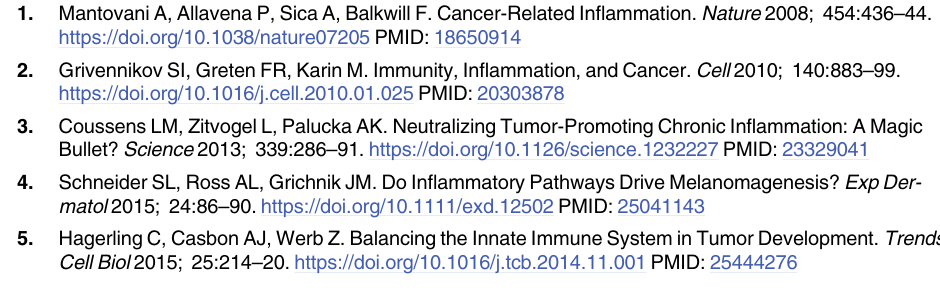
S2 Fig. The effect of IL-1 β on cellular invasion (a) and adhesion (b). a, In melanoma cells, cellular invasion was undetectable. b, Cellular adhesion of IL-1 β , UK356618, and UK356618+ IL-1 β -treated cells showed no significant difference compared to control. Data are shown as the mean ± standard error of three independent